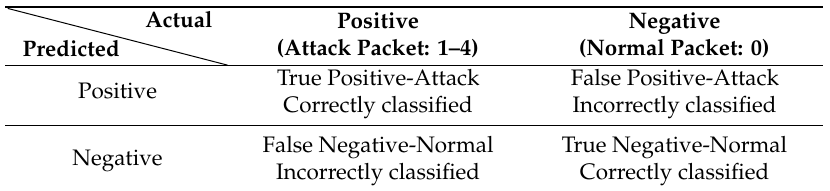
Table 3. NSL-KDD